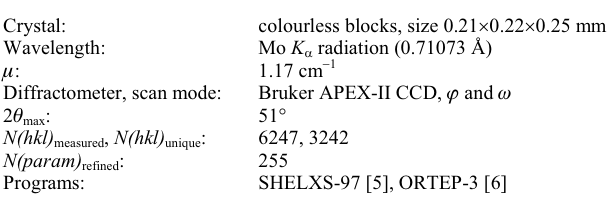
Table 1. Data collection and handling.